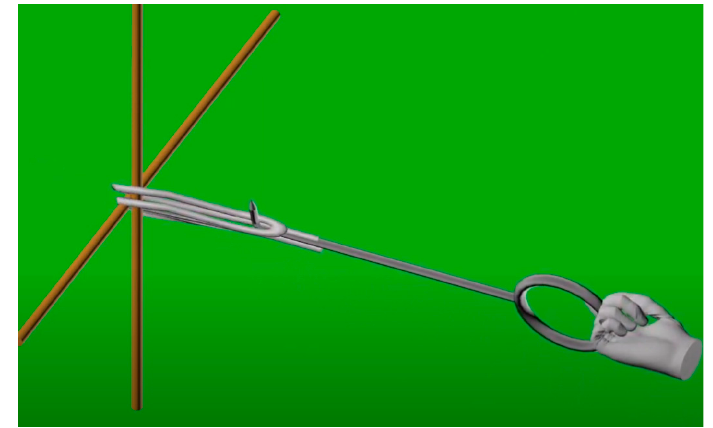
Figure 9. A cyber-based environment of the glove’s application.